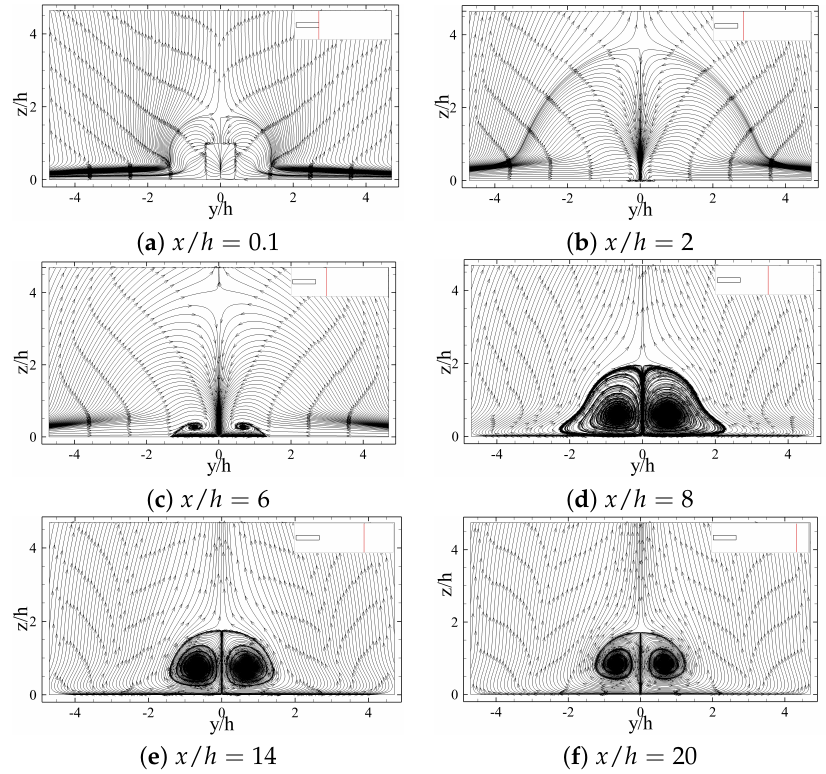
Figure 20. Mean streamlines on zy -planes at in the wake of the long